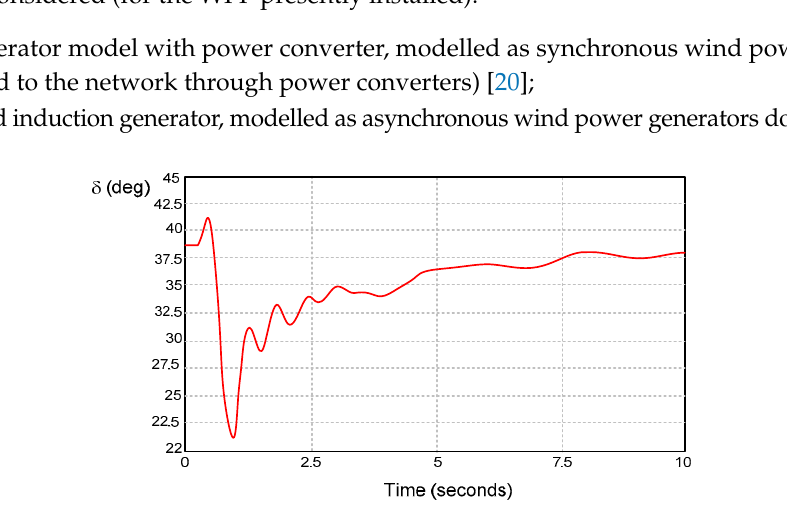
Figure 12. Internal angle of classical generator from thermal power plant connected at bus RPALAST in case of short-circuit on a 110 kV line.